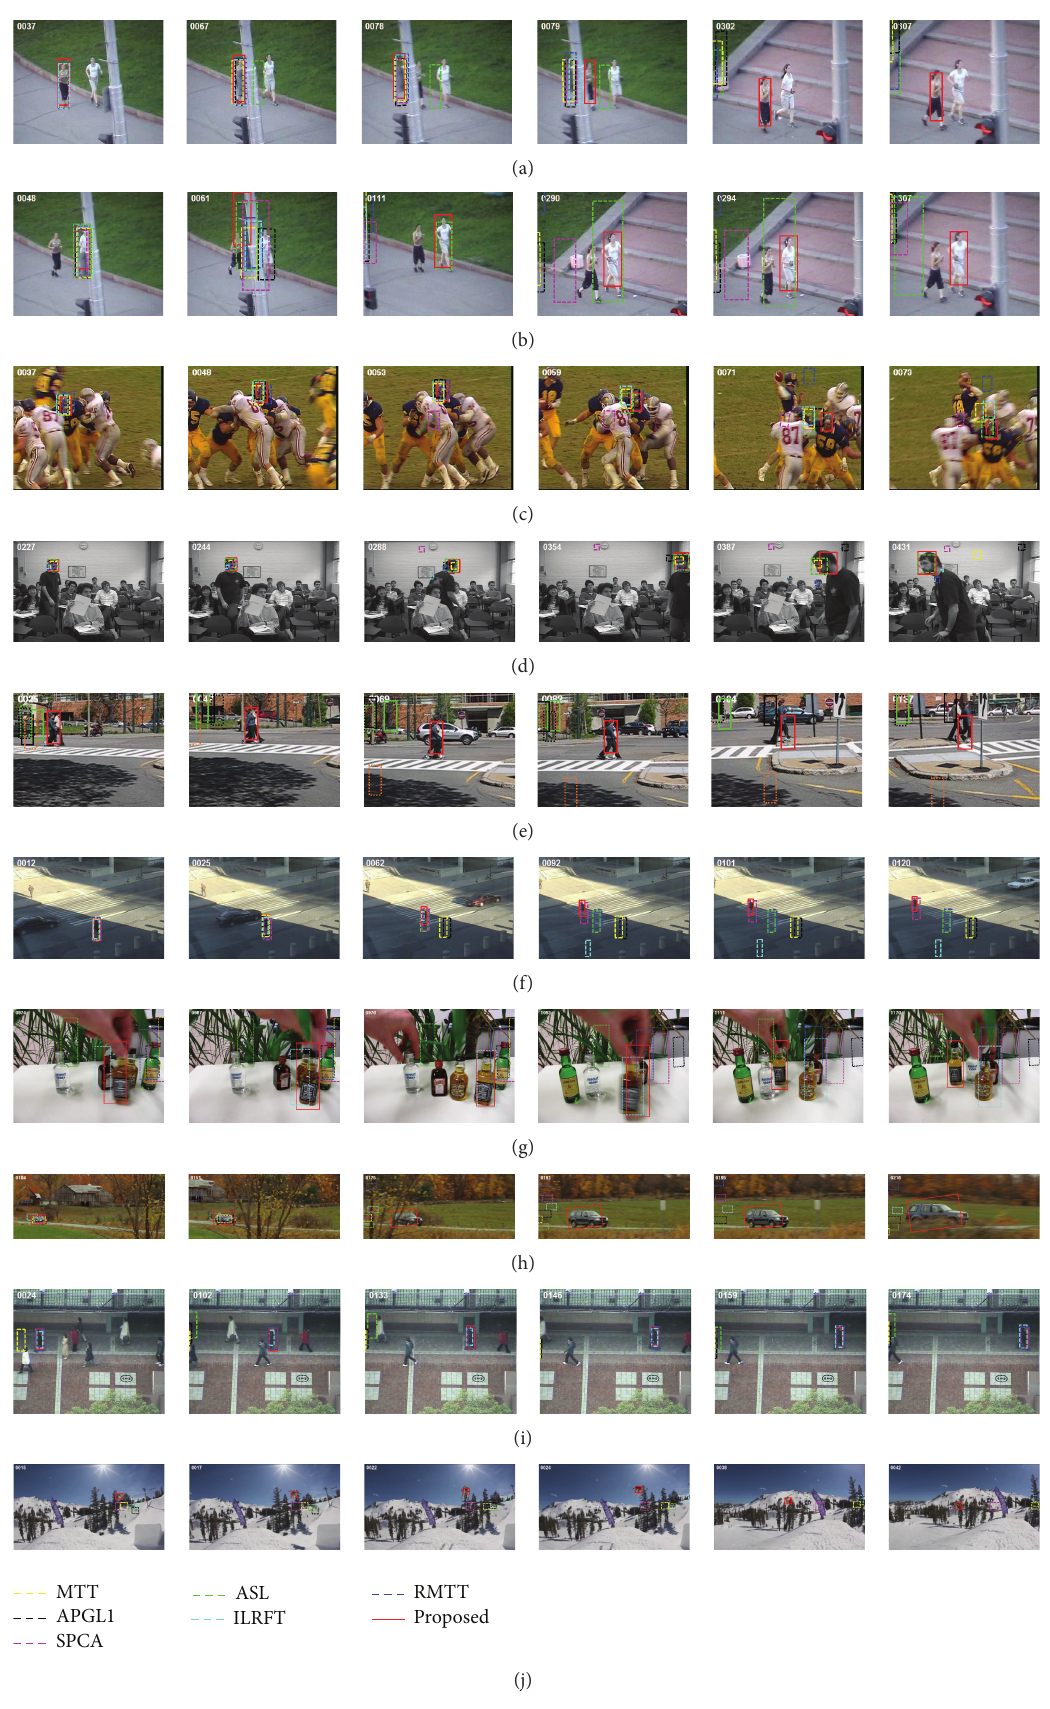
Figure 3: Object tracking results using seven different algorithms on ten test sequences. They are Jogging 1, Jogging 2, Football 1, Freeman 3, Couple, Crossing, Liquor, Car Scale, Subway, and Skiing, respectively, from the top row to the bottom